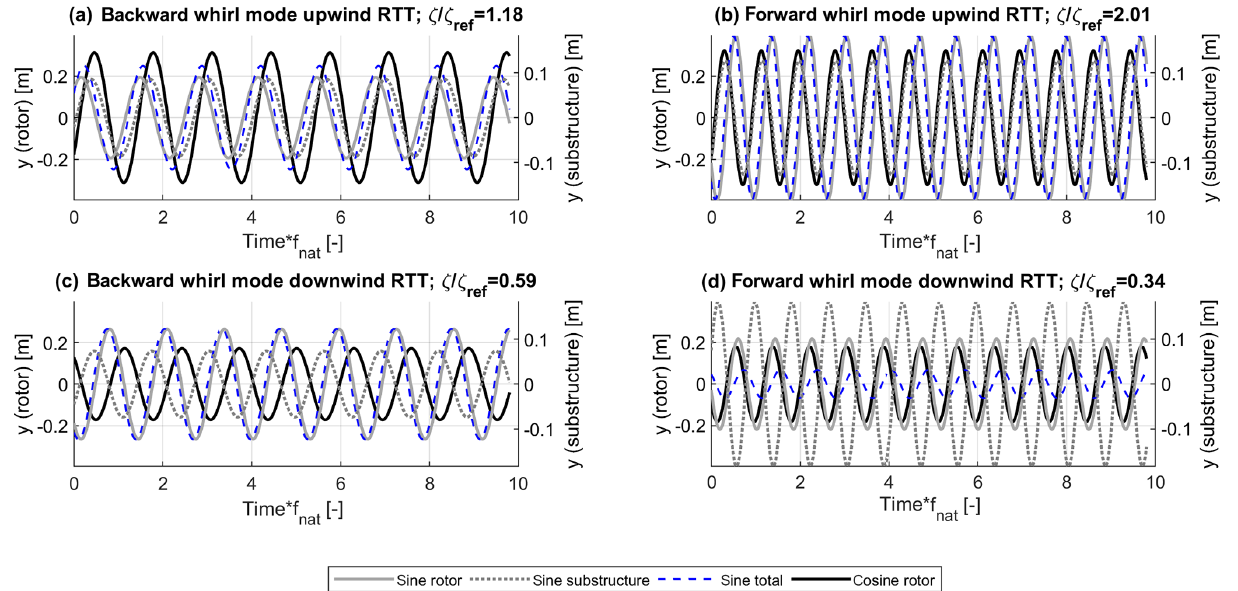
Figure A2. Modal out-of-plane displacements at 9ms − 1 and a cone angle of 7.5 ◦ for the backward whirl mode and forward whirl mode of the upwind RTT and downwind RTT configurations. The time axis is normalized with the blade edgewise natural frequency.